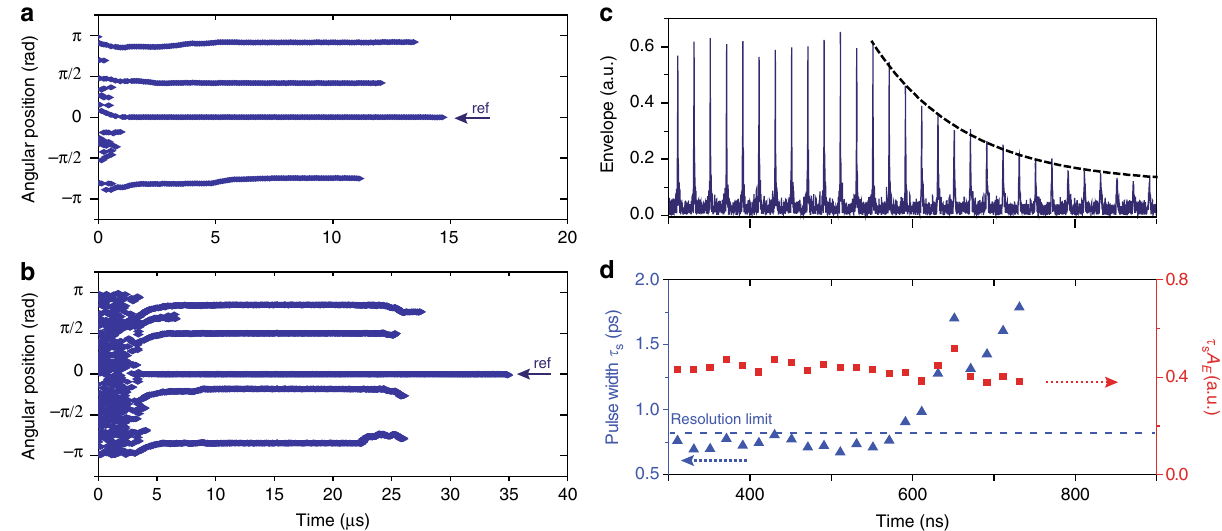
Fig. 4 Measurement of relative soliton positions and soliton decay. a Plot of the relative positions of four solitons while the pumping laser frequency is scanned (high to low). The reference soliton, used to establish zero angular position, is indicated and all solitons have stable relative positions after only several μ s of motion. b The relative positions of fi ve solitons is measured versus time as the pump laser frequency is scanned. The soliton relative positions stabilize and then destabilize at 22 μ s. The frame rates for a and b are 10 and 50 MHz, respectively. c Interferogram envelope showing a single soliton experiencing decay. An exponential fi tting is given as the dashed black line. d The measured pulse width (blue) is plotted versus time and its resolution limit (dashed blue line) is set by the EO comb pulse width. The product of soliton amplitude and pulse width is plotted in